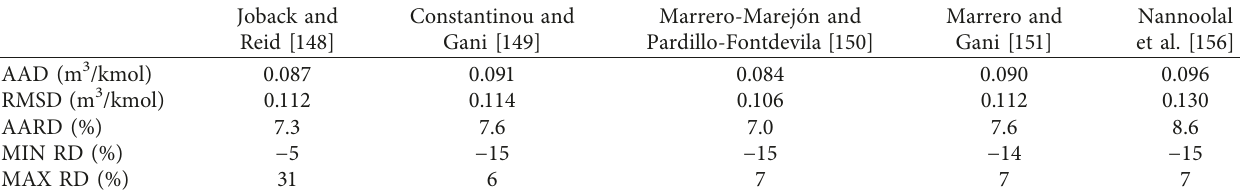
Table 17: Deviations of different methods for the estimation of the critical volume.